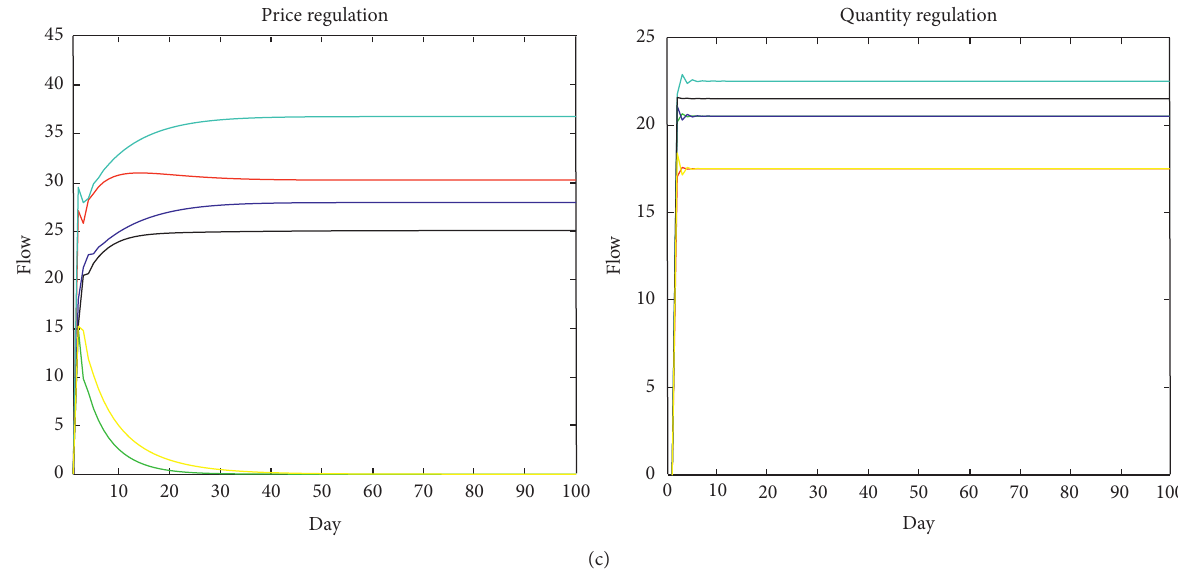
Figure 4: Flow evolution of test traffic network with different traffic flow proportional adjustment ratios. (a) α � 0 . 1. (b) α � 0 . 3. (c) α � 0 .